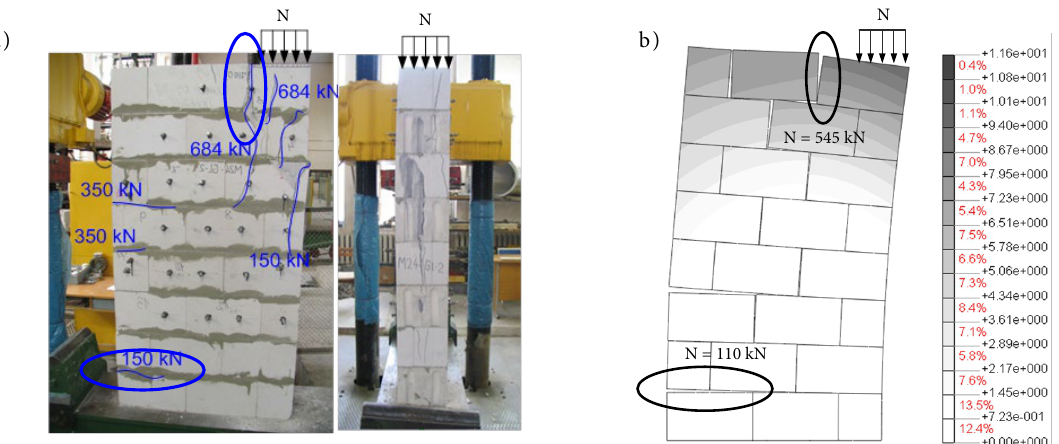
Figure 8. Cracks distribution and crack formation loads: a) experimental research; b) numerical modeling